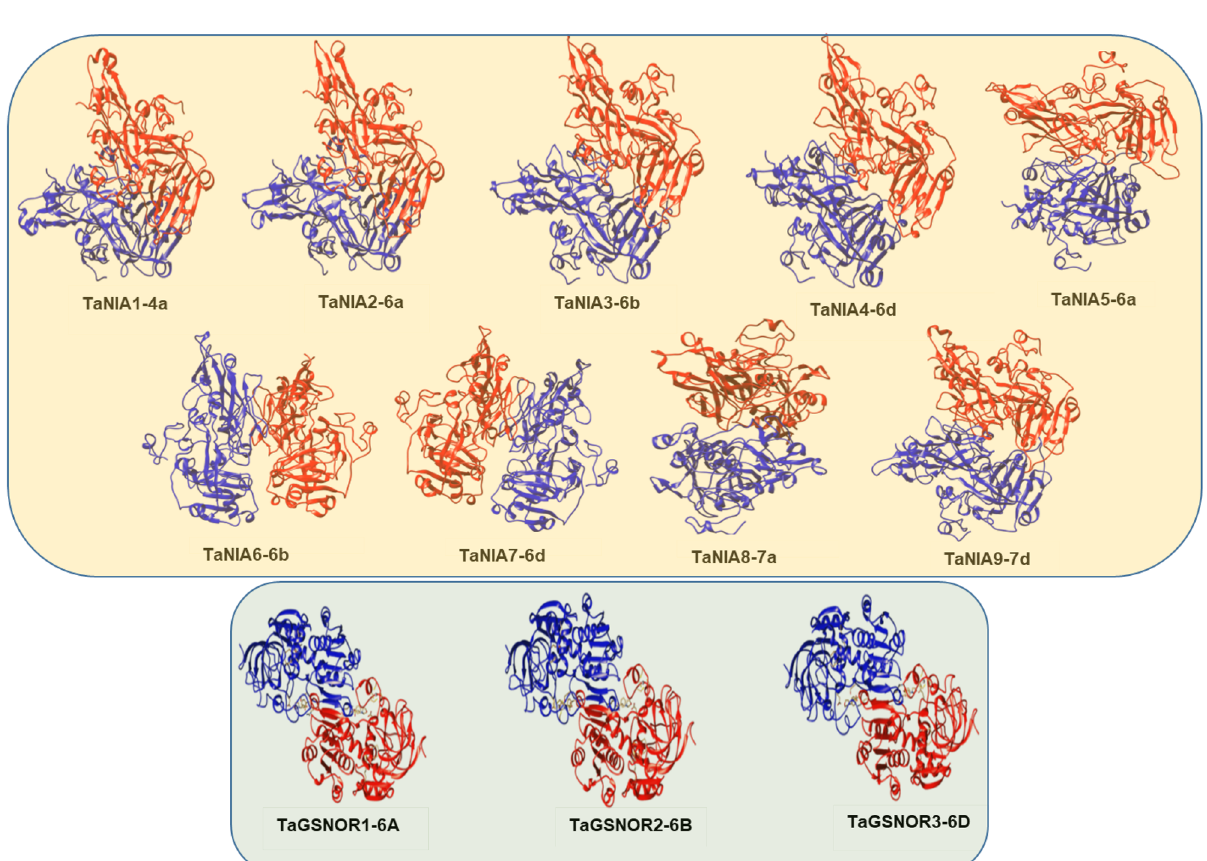
Figure 4. Homology modeling of TaNIA ( a ) and TaGSNOR ( b ) proteins constructed using automated Swiss- Model server by comparing template 2bih.1. A (Nitrate reductase [NADPH domain]) and 4dl9.1. A (Alcohol dehydrogenase class III) respectively and visualized in UCSF CHIMERA to generate 3D images (https:// www. cgl. ucsf. edu/ chime